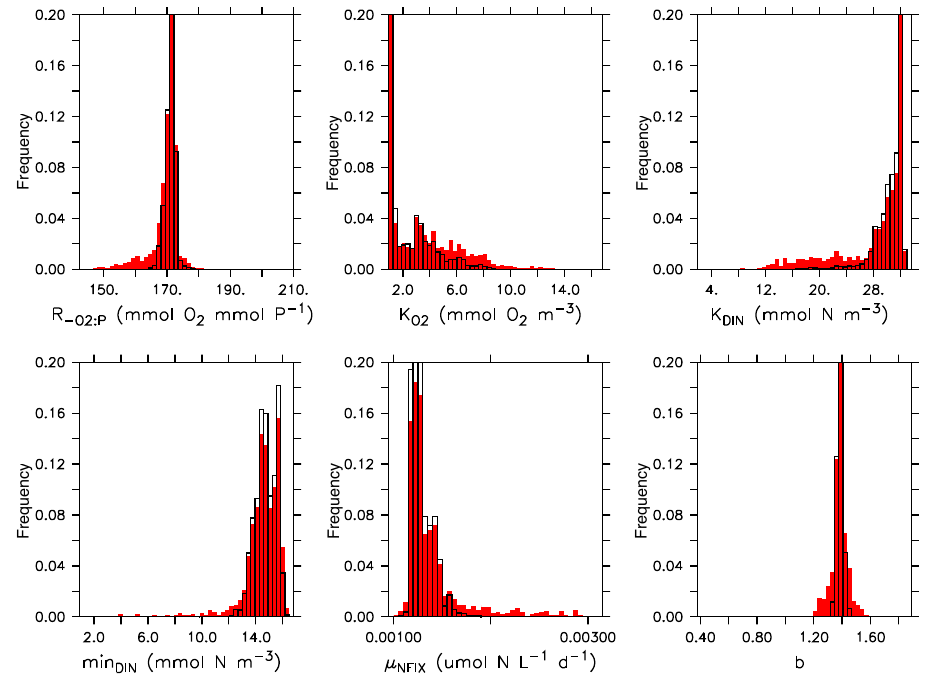
◦ D , whose misfit do not exceed a threshold